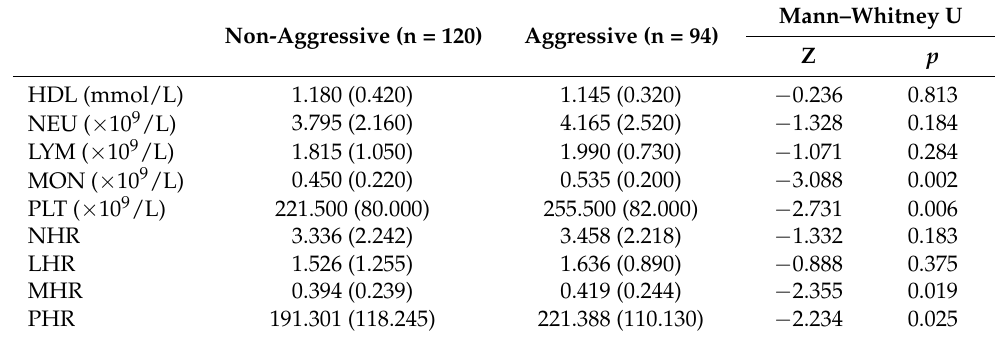
Table 2. Comparison of HDL, PLT, LYM, MON, LYM, NEU, PHR, NHR and MHR in the two groups. Non-Aggressive (n =